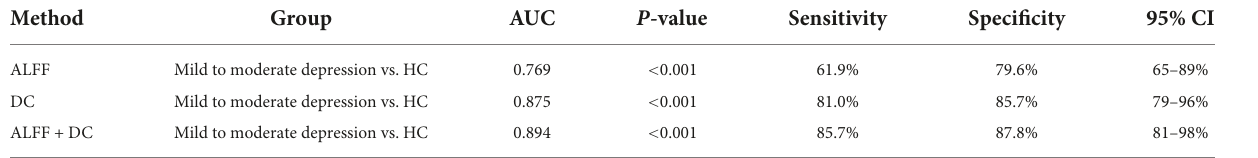
TABLE 4 ROC and AUC of amplitude of low-frequency fluctuation (ALFF), degree centrality (DC).